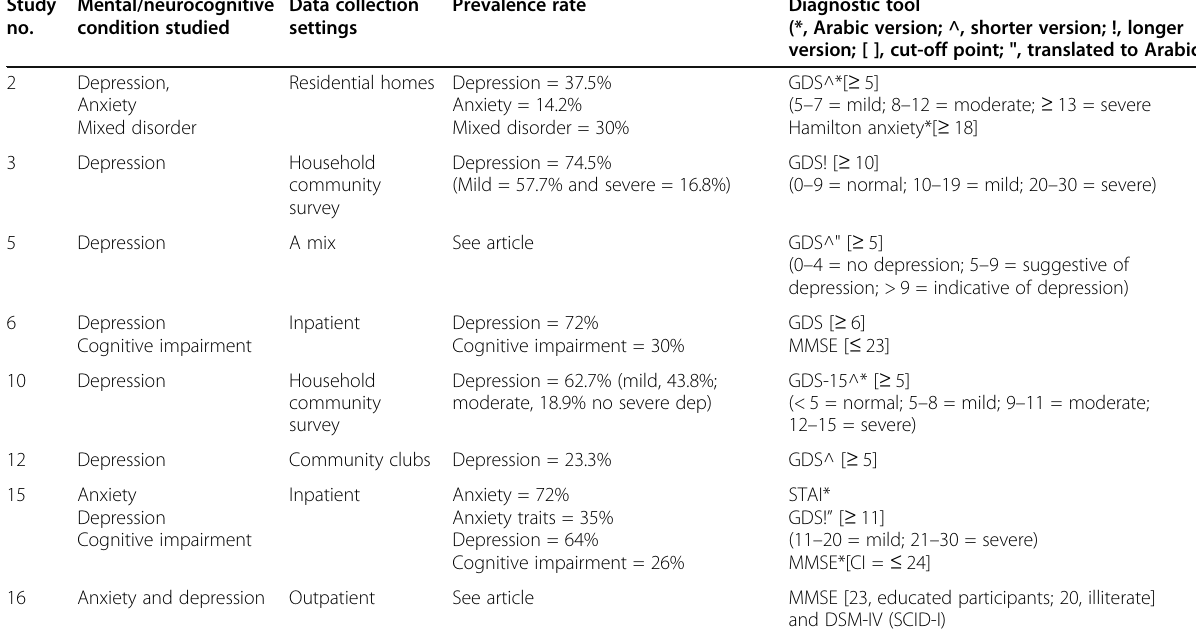
Table 3 Prevalence of depression and anxiety Study